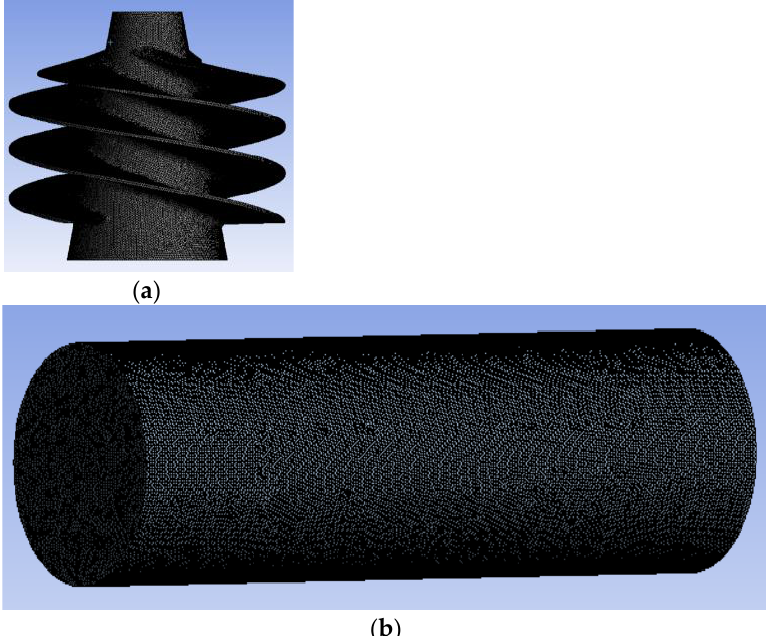
Figure 3. Meshing diagram of the three blades inducer and fluid domain. ( a ) Mesh of inducer; ( b ) Mesh of fluid domain.